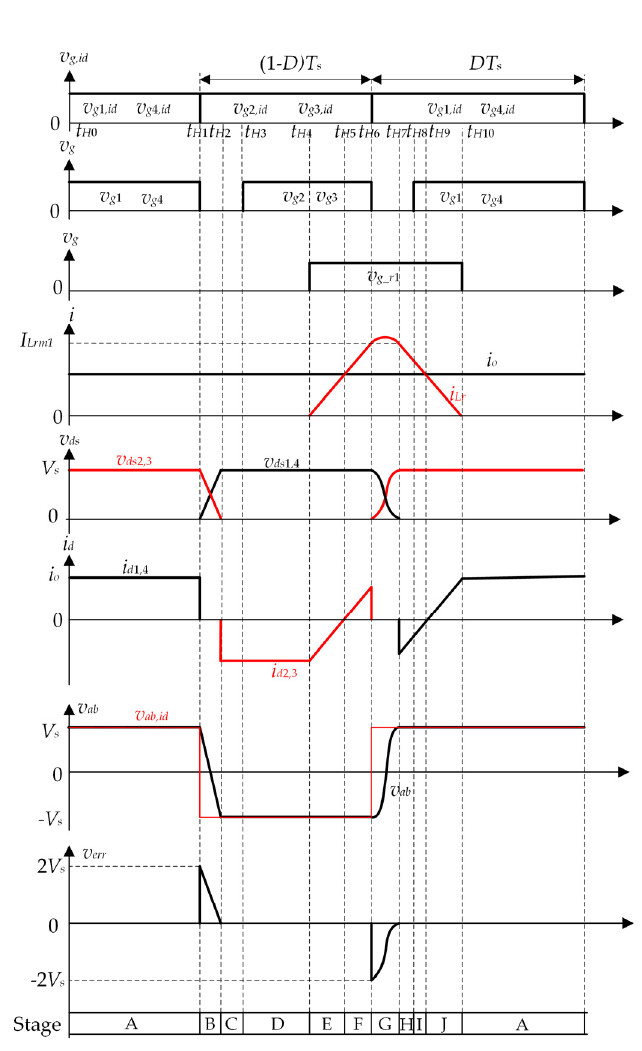
Figure 2. Key waveforms of the the auxiliary resonant snubber inverter (ARSI) in the heavy load condition.